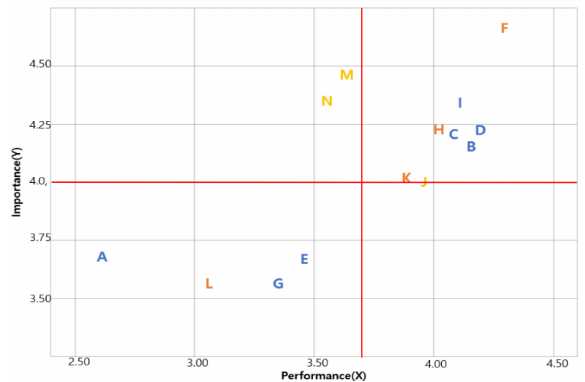
Figure 4. IPA (young group).